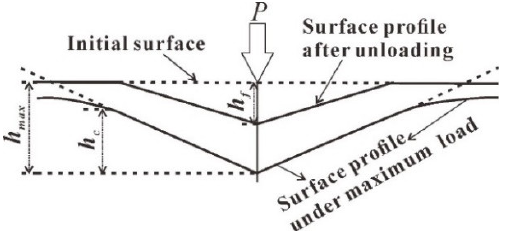
Figure 2. Schematic and parameters of nanoindentation. h max is the maximum depth; h c is the contact depth; P is the loading pressure.